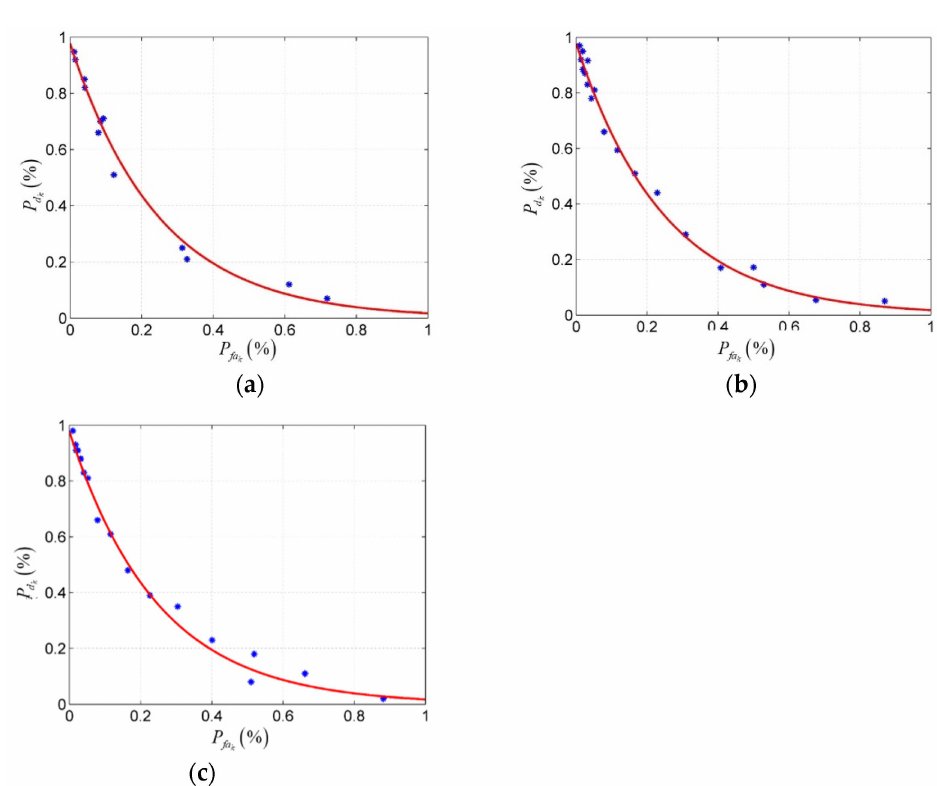
Figure 4. Correct ranging probability ( P d ) when the detected signal codes number equals the signal recognition threshold k and incorrect ranging probability ( P fa ) when the detected noise codes number is equal to or greater than the signal k recognition threshold under different system parameters. ( a ) Under different sequence length; ( b ) Under different pulse count density; ( c ) Under different noise count